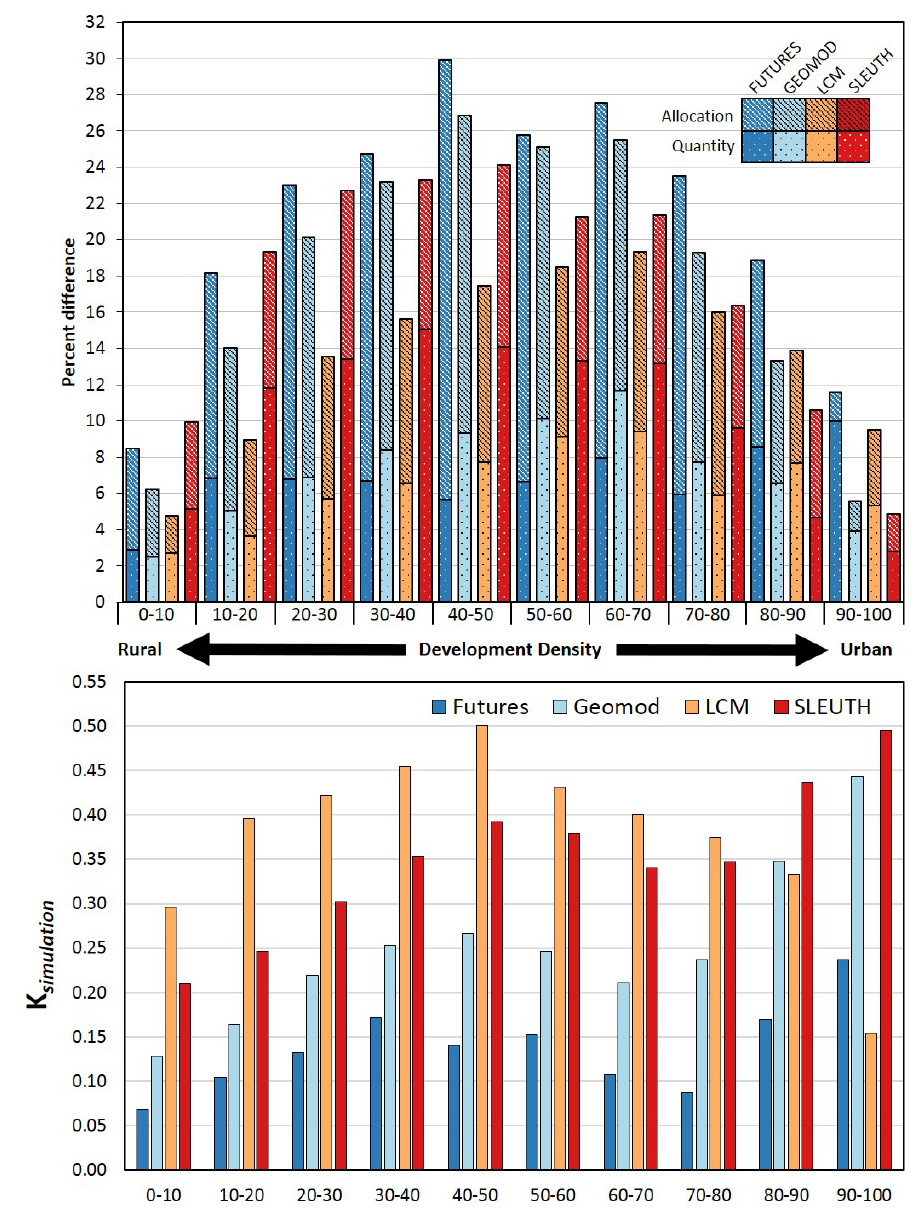
Figure 4. Average quantity and allocation disagreement (top) and K simulation values (bottom) based on the percent of development within each 5 × 5 km grid within the ten county study